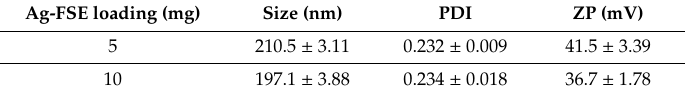
Table 3. Effects of drug loading on size, PDI, and ZP of CSNPs.